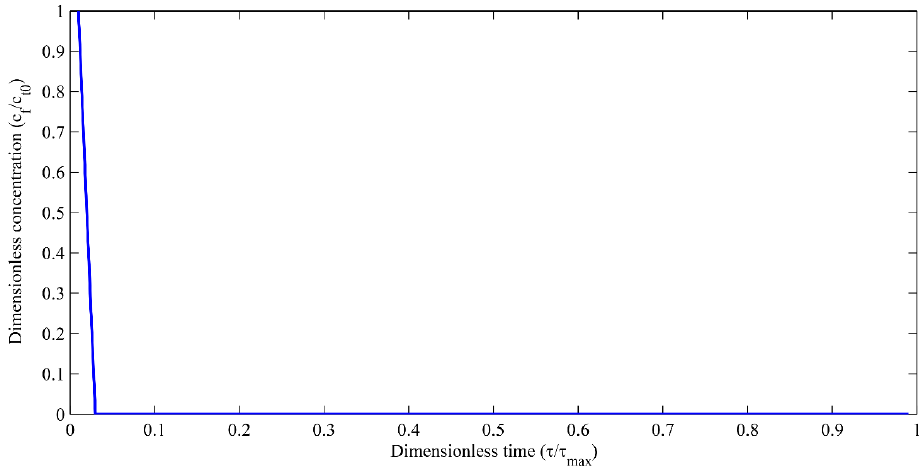
Figure 6. Dimensionless autocatalytic concentration versus dimensionless time for k = 0.05.